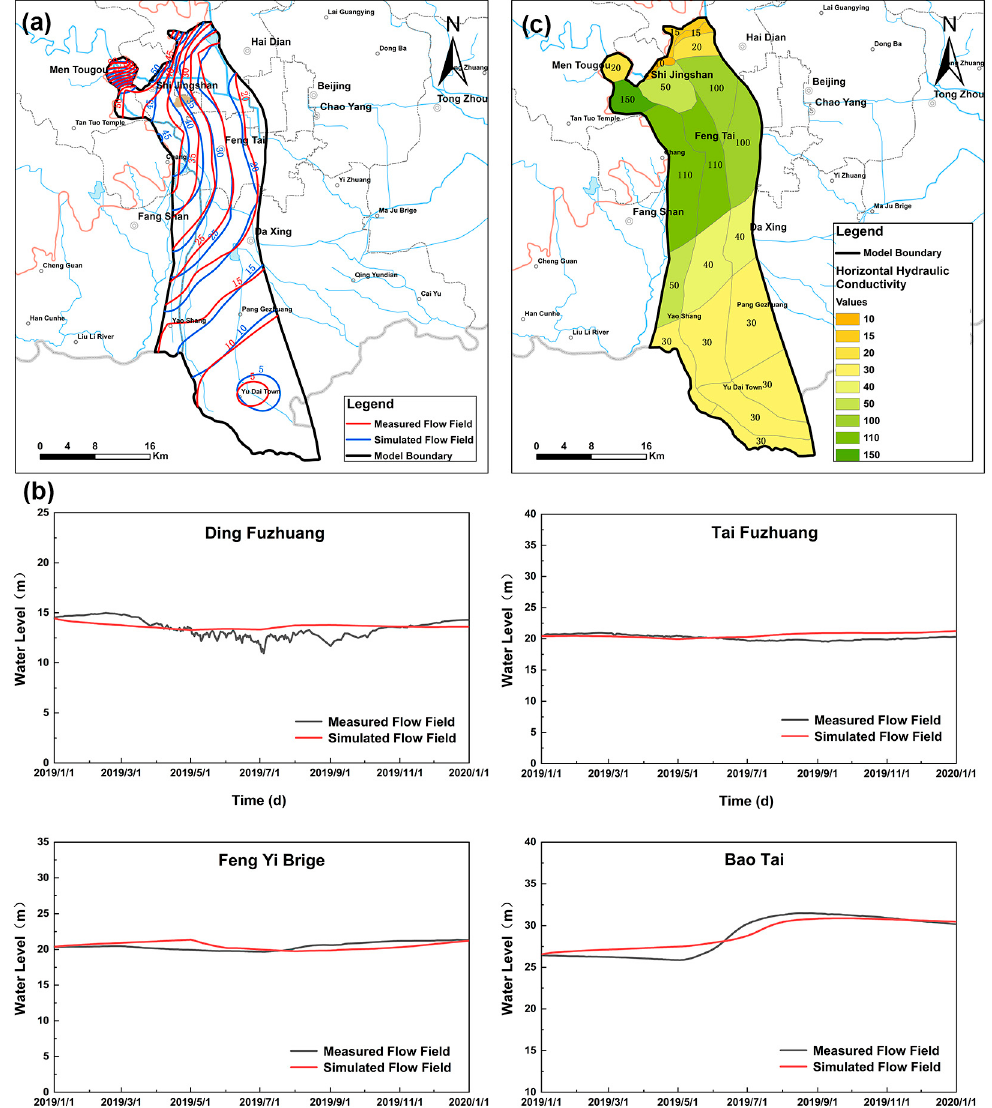
Figure 6. ( a ) Flow-field fitting diagram at the end of the simulation period. ( b ) The fitting curve of typical observation well in the ecological water supplement region. ( c ) Identification verified the aquifer parameter-zoning diagram (m/d). Table 2. Groundwater zone budget in the study area in